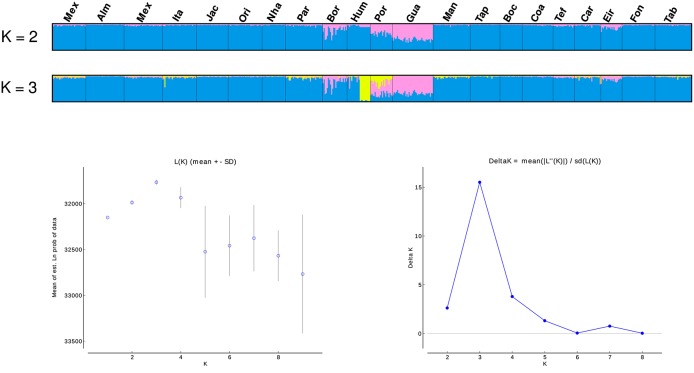
Population structure based on STRUCTURE analysis (K = 2, and K = 3) of 13 microsatellites. Each vertical bar represents an individual. Estimates of the number of populations (K) based on the mean likelihood Ln (K) and the delta K statistic (Evanno et al., 2005). Locality codes are: Mexiana (Mex), Almeirim (Alm), Santarém (San), Itaituba (Ita), Jacareacanga (Jac), Oriximiná (Ori), Nhamundá (Nha), Parintins (Pin), Borba (Bor), Humaitá (Hum), Porto Velho (Pve), Guajará-Mirim (Gua), Manaus (Mao), Tapauá (Tap), Boca do Acre (Bda), Coari (Coa), Tefé (Tef), Carauari (Car), Eirunepé (Eir), Fonte Boa (Fbo), Tabatinga (Tab).